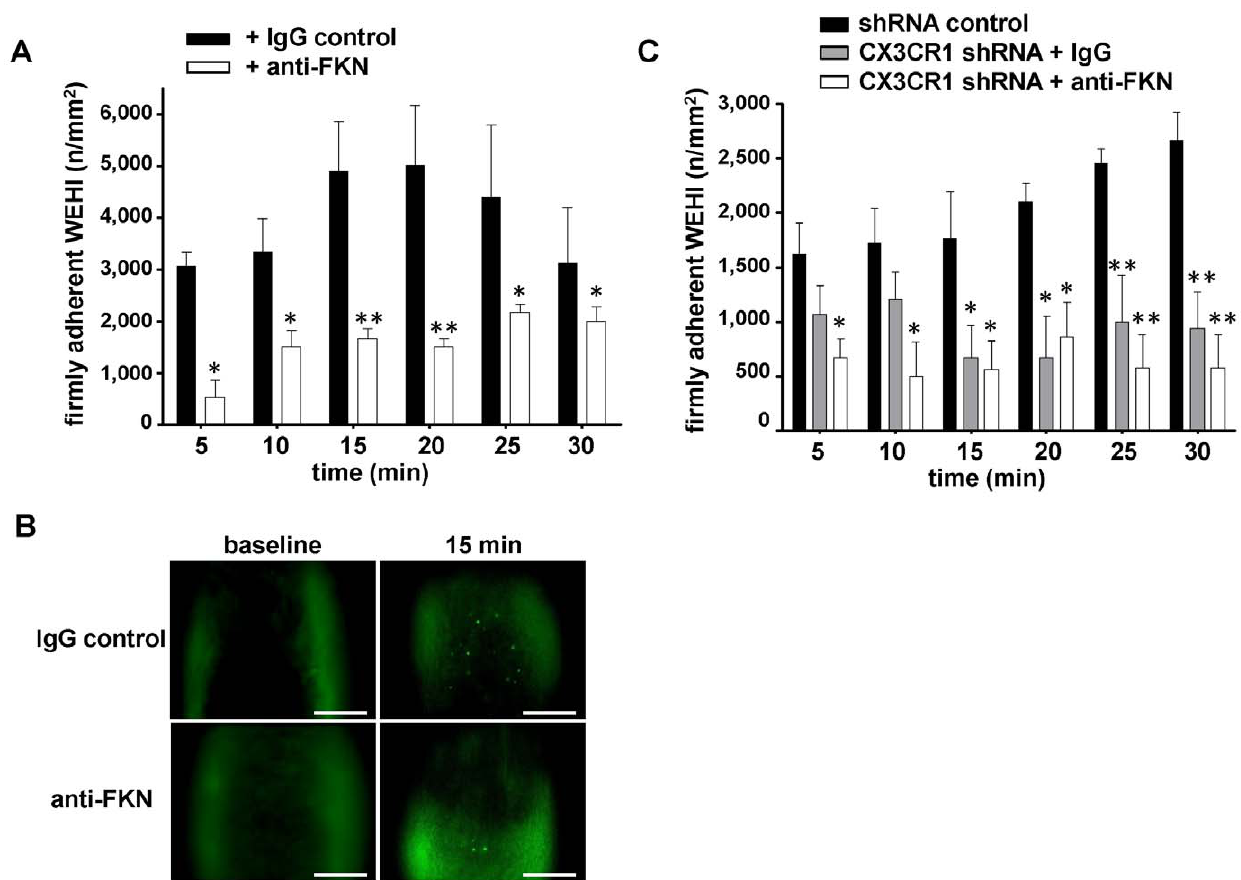
Figure 6. FKN and CX3CR1 mediate WEHI 274.1 recruitment to injured atherosclerotic carotid arteries. ( A ) WEHI 274.1 adhesion to mechanically injured atherosclerotic carotids was studied over 30 minutes in the presence of an IgG control antibody (black bars) or a function blocking anti-FKN antibody (white bars). ( B ) Representative intravital microscopic images from mouse carotid arteries at baseline (left) and 15 minutes (right) after injury of the atherosclerotic vascular wall, pretreated with either an anti-FKN antibody (upper row) or an isotype IgG control antibody (lower row). WEHI 274.1 cells were stained with DCF (green). Bars, 50 m m. n=4–8, *p , 0.05, **p , 0.01. ( C ) WEHI 274.1 adhesion is dependent on FKN-CX3CR1 interactions. WEHI 274.1 were transfected with shRNA-encoding plasmids to silence CX3CR1 expression (grey and white bars) or transfected with a plasmid encoding a scrambled control shRNA (black bars). Prior to transfusion the animals were pretreated either with a rabbit IgG control antibody (grey bars) or a function blocking anti-FKN antibody (white bars). WEHI 274.1 adhesion to injured atherosclerotic carotids was analyzed over 30 minutes.